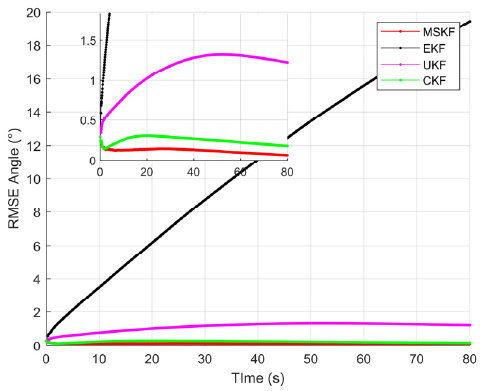
Figure 9. Angle estimation accuracy of CL distribution.